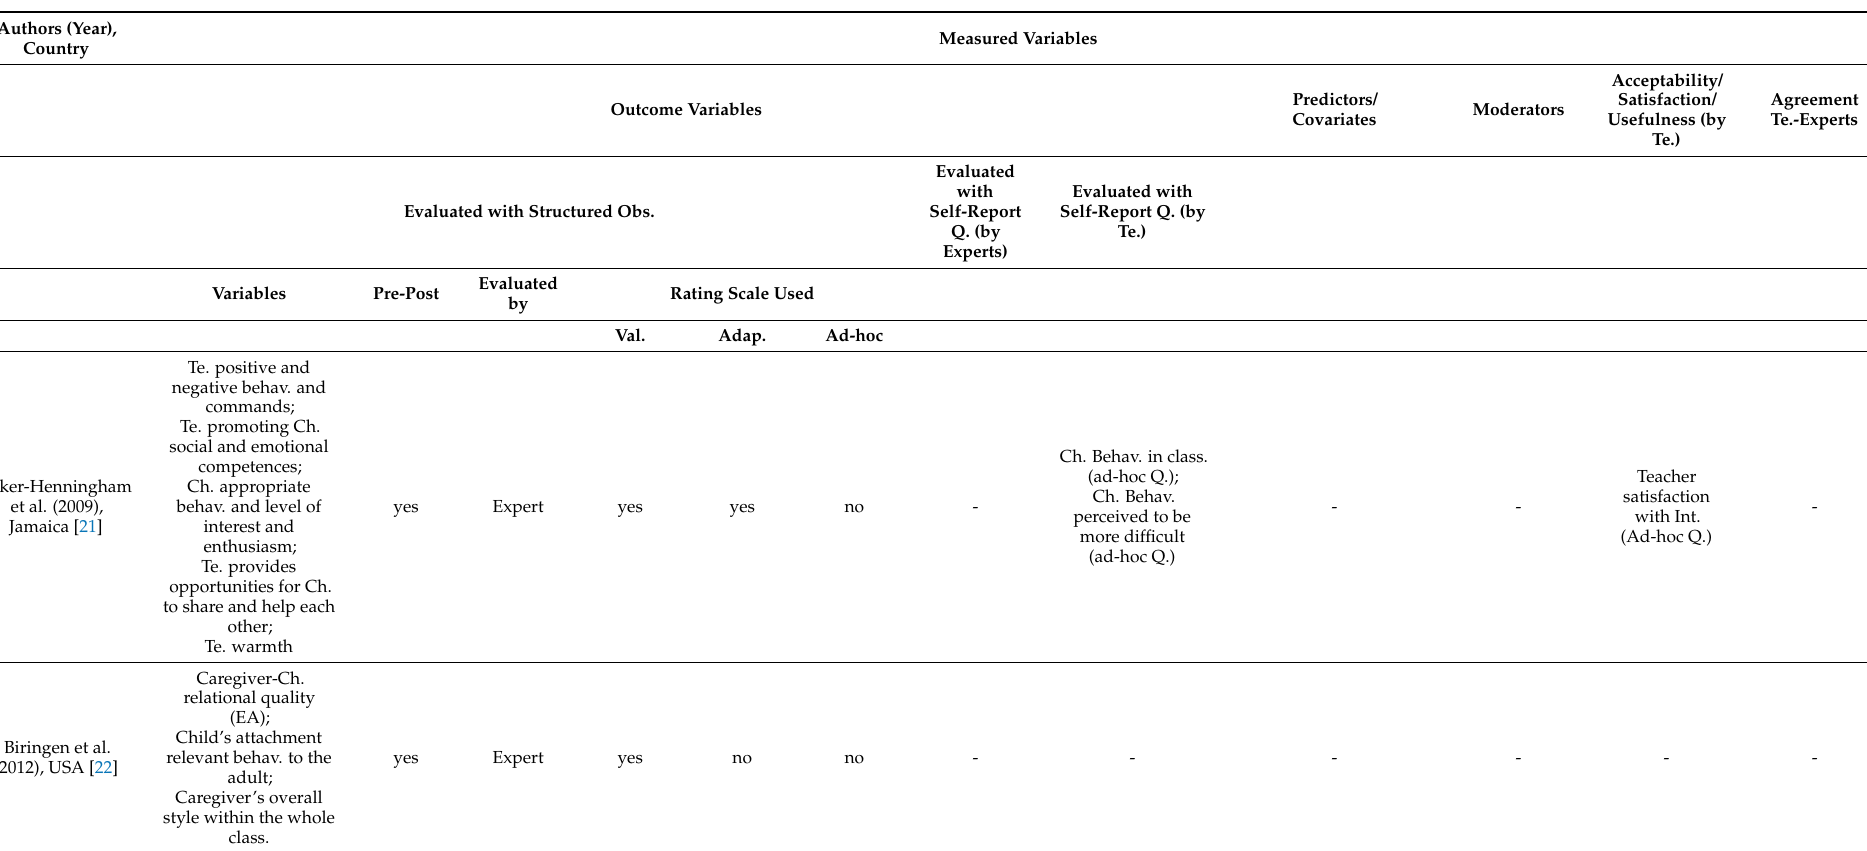
Table 3. Measured